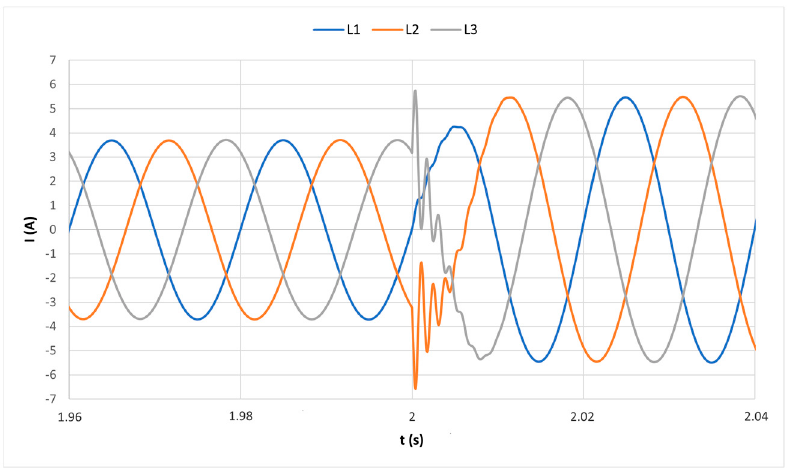
Figure 14. Simulated values of PV station model currents during a 3-Ph ground fault condition at the source.